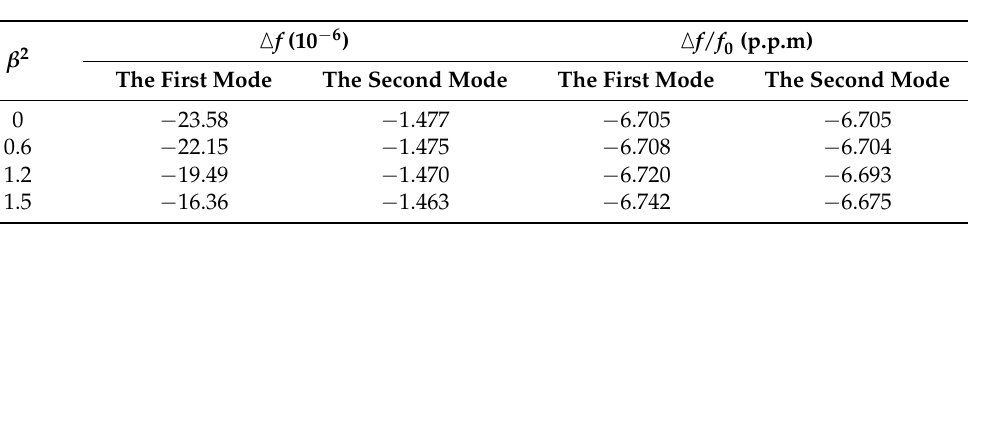
Figure 9. The distribution of the centripetal force for the first and second mode shape.